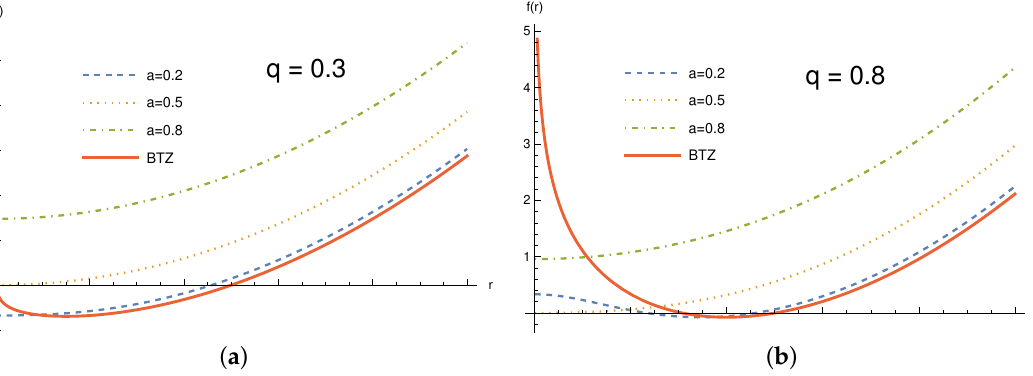
Figure 6. Plot of f ( r ) for the Simpson–Visser charged BTZ black hole. We used for this plot M = 1 and l = 0.5. ( a ) stands for q = 0.3 and ( b ) stands for q =